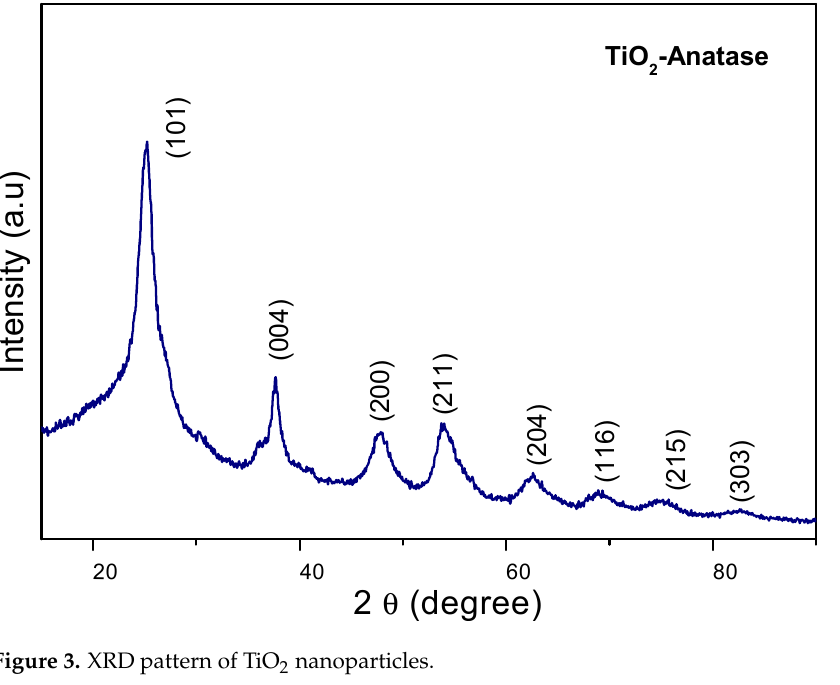
Figure 3. XRD pattern of TiO 2 nanoparticles. FTIR spectrum (Figure 4) shows the band at 544 cm − 1 attributed to Ti–O–Ti stretching vibration [27]. The band at 1134 cm − 1 is the characteristic peak of aliphatic (Ionic liquid) in-plane vibrations [28]. The bands at 1400 cm − 1 and 1640 cm − 1 are attributed to the in- plane vibrations and C–H stretching of the imidazolium ring, respectively [29]. The band at 3400 cm − 1 is indexed to the stretching vibration of the O–H bond.